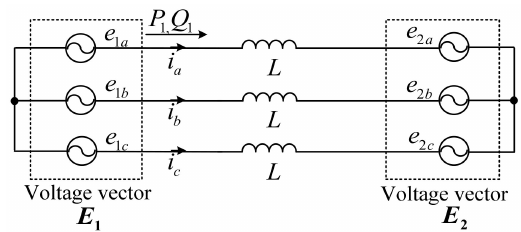
Figure 5. A two-node three-phase inductance circuit with voltage vectors E 1 and E 2 as the